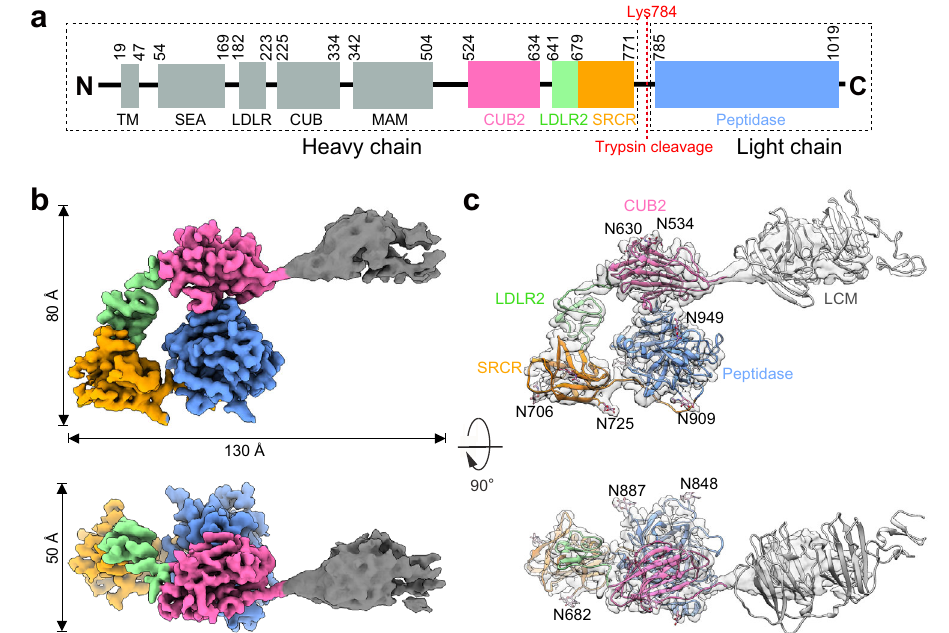
Fig.1|Cryo-EMstructureof h EPintheinactivestate.a Domainsof h EP.Numbers indicatetheN-orC-terminuspositionsofthedomainsintheaminoacidsequence. The unexpressed domains (TM and SEA), as well as the fl exible domains with a lower resolution (LDLR, CUB, and MAM), were colored in grey, CUB2 domain in pink, LDLR2 domain in light green, SRCR domain in orange, and the